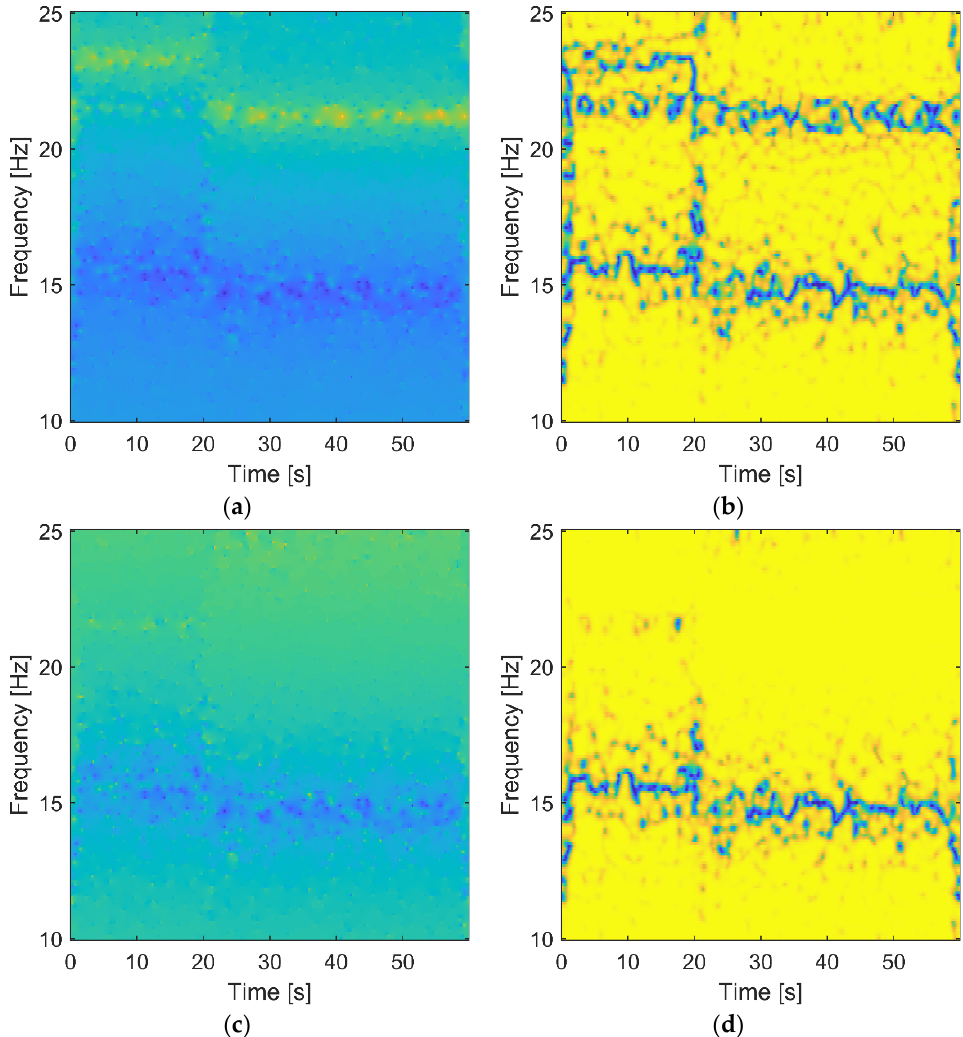
Figure 9. Wavelet-based analysis for the two-story building: ( a ) wavelet-based FRF in logarithmic scale; ( b ) wavelet-based FRF coherence; ( c ) wavelet-based transmittance; ( d ) wavelet-based transmittance coherence.